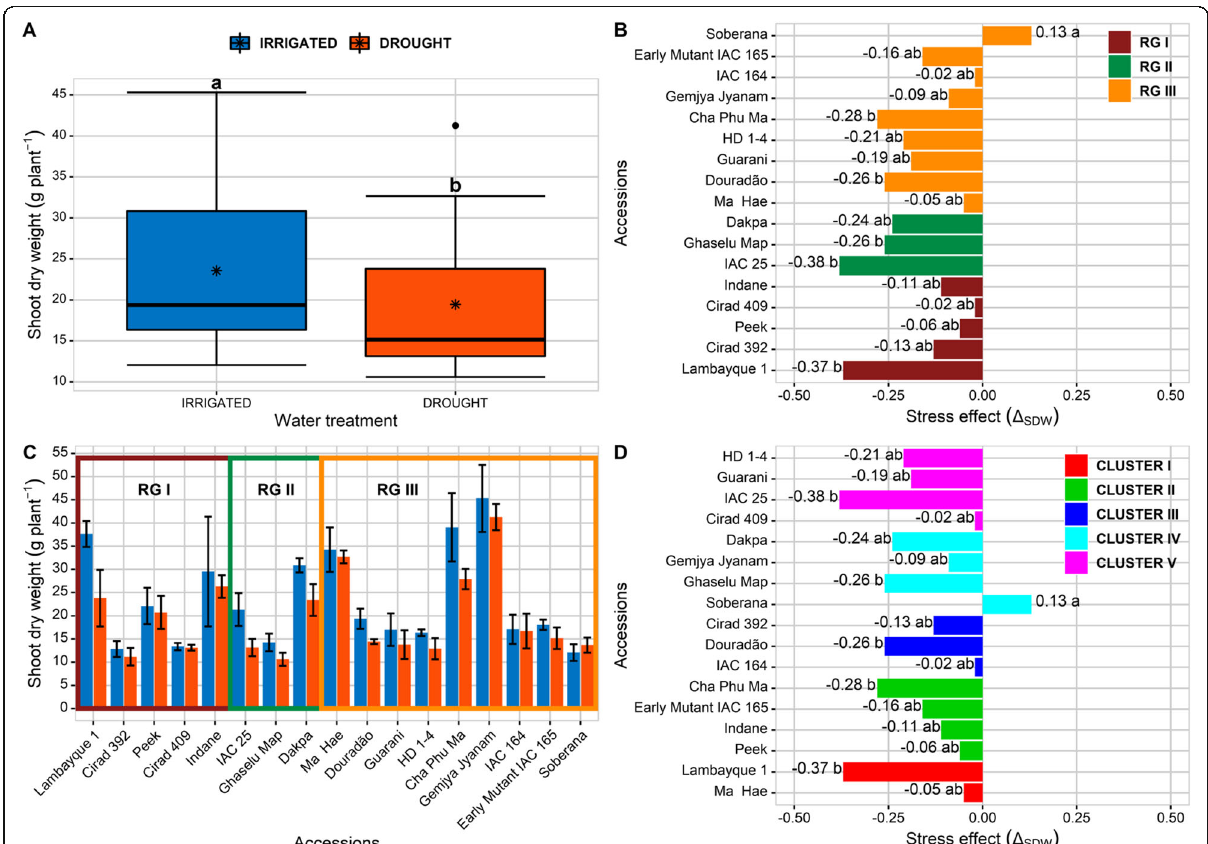
Fig. 4 Shoot dry weight ( SDW ) of 17 accessions under two water conditions. (A) Box-plots showing the SDW under irrigated and drought conditions , (B) Shoot drought response ( Δ SDW ) for each accession according to its membership to one response group , (C) Shoot dry weight of each accession under two water conditions , (D) Shoot drought response ( Δ SDW ) for each accession according to its membership to one cluster . * The averages followed by the same letter do not differ statistically according to the Tukey test (p-value 0.05) . RG: response group. Values are means of three replicates ±